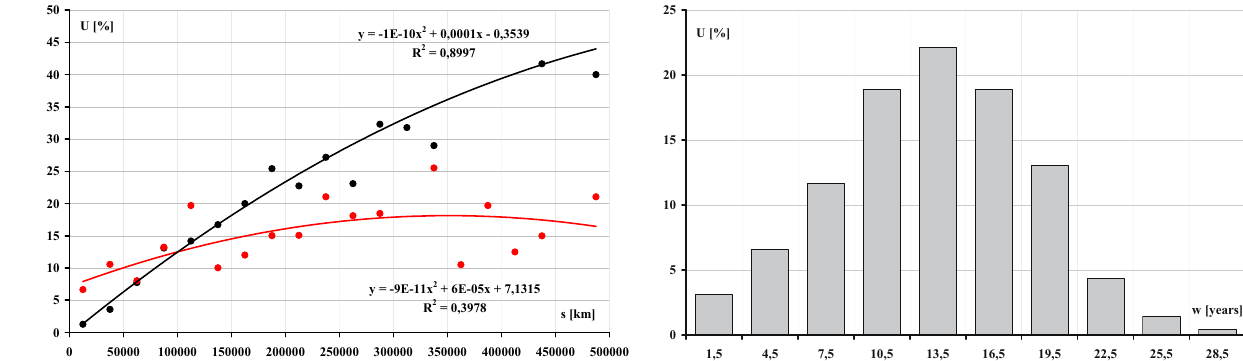
Figure 5: Vehicle age histogram.